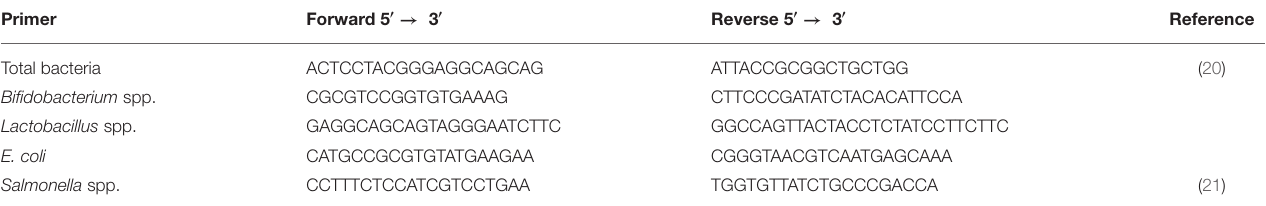
TABLE 2 | Specific bacteria primers used in this